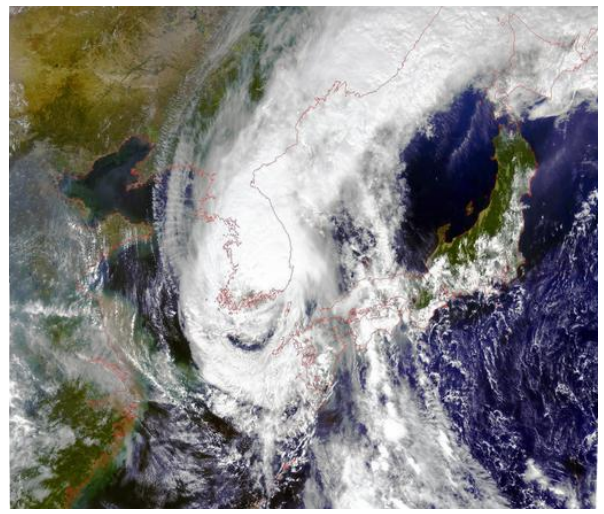
Figure 1. Satellite Chollian GOCI RGB Synthetic image for Ty- phoon